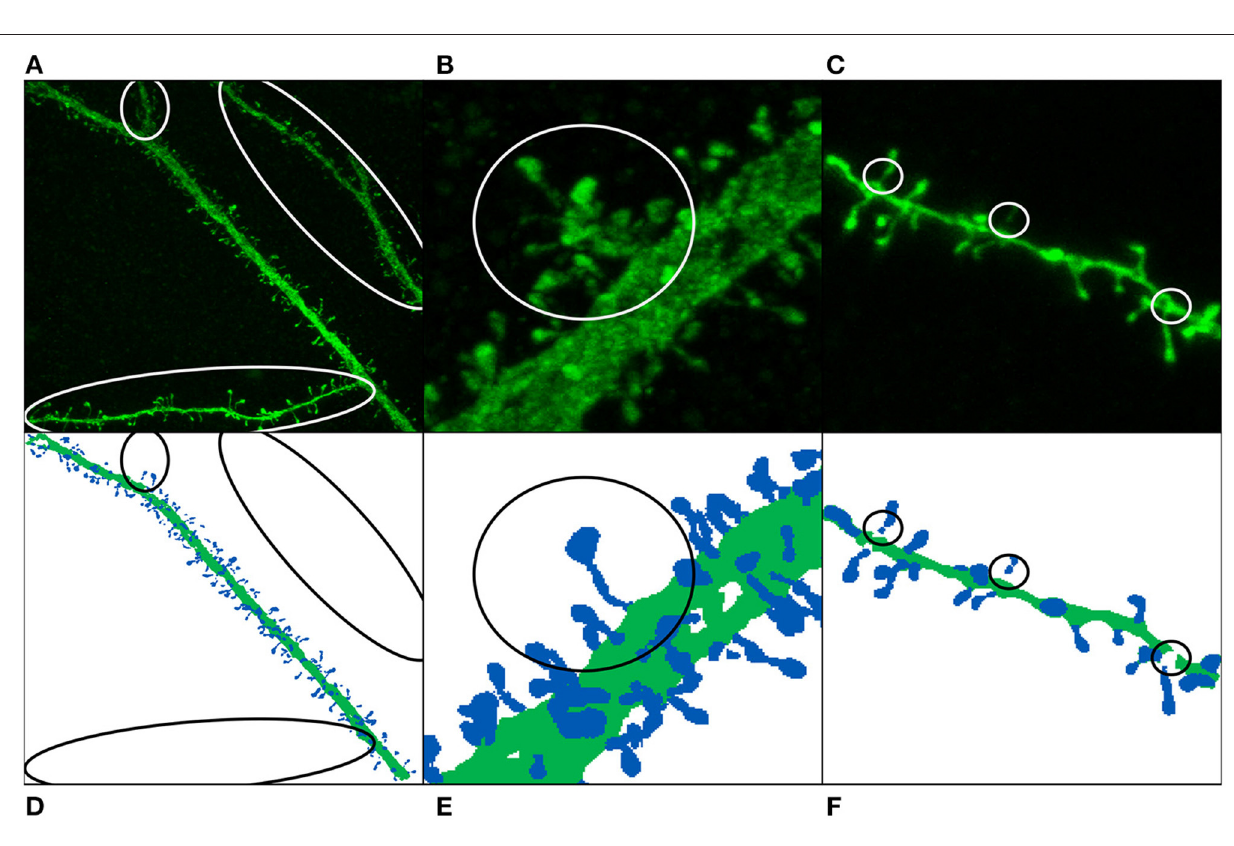
FIGURE 4 | Image annotation issues: missing dendritic shafts or spines (A–E) and unattached components (C,F) . (A–C) Display the maximum projection of the confocal images, and (D–F) show their corresponding segmented image. Manually segmented spines are displayed in dark blue, whereas dendritic shafts are represented using dark green. (A,D) The main apical dendrite (and not the collateral dendrites) was selected to be reconstructed. (B,E) Non-segmented collateral spines and dendritic shafts are, especially troublesome when they are close to the main branch. (C,F) The annotated image shows gaps in the dendritic shaft and spine necks, mainly because the dendritic shaft and some spines were reconstructed using several